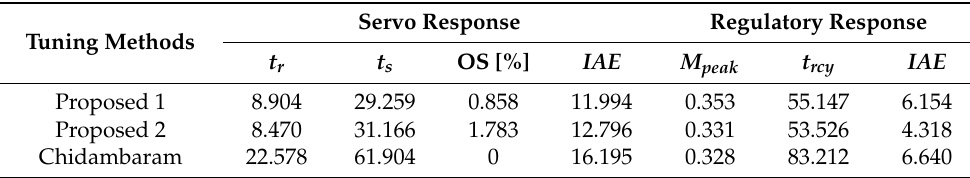
Figure 8. Unit step responses for nominal process 𝑃 3 . Table 8. Performance comparisons for nominal process P 3